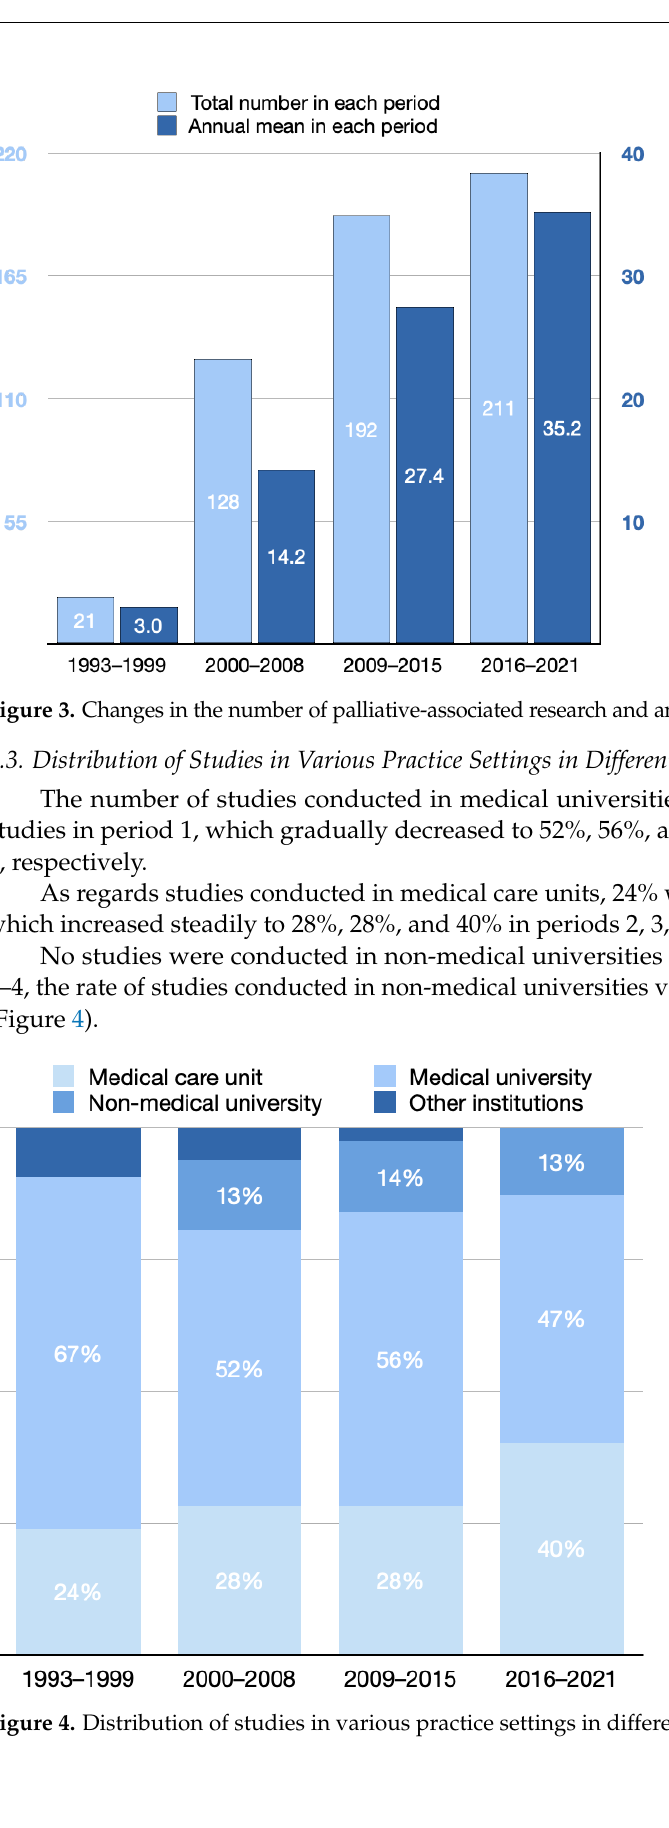
Figure 4. Distribution of studies in various practice settings in different periods.